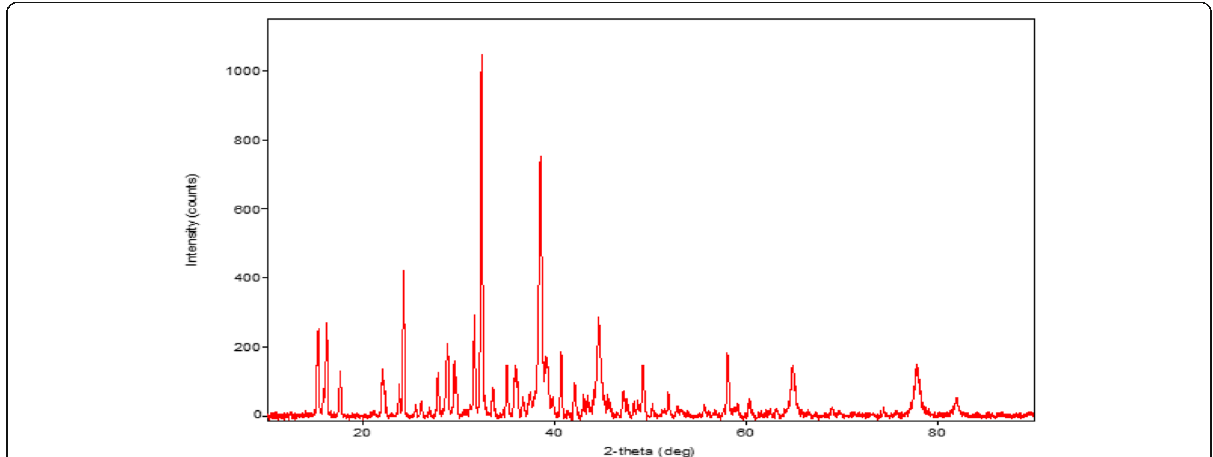
Fig. 2 X-ray diffractogram of chemically synthesized silver